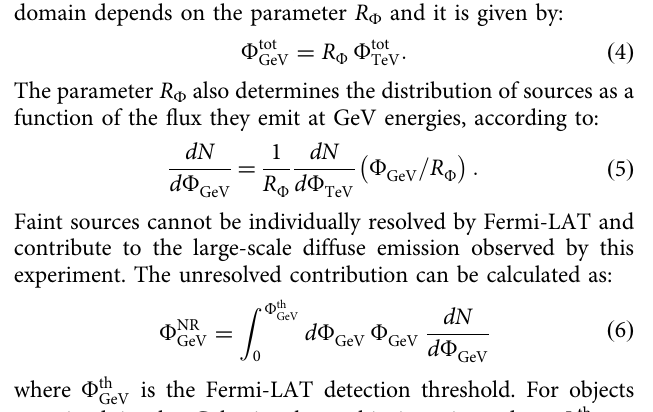
Fig. 1. The decrease of the best- fi t spectral indexes Γ 1 in the inner rings with respect to the locally observed value, see second column of Table 2, has been considered as the evidence of a progressive large-scale hardening of CRs spectrum toward the Galactic Center. The same conclusion was obtained by previous analyses on the subject 3,4 performed by using a similar approach. One can get a visual perception of the situation by comparing the green dashed lines with the gray solid lines in Fig. 1 that describe power laws with spectral index fi xed at the local value, i.e., ~2.7, suitably normalized to reproduce the observed fl ux at 2